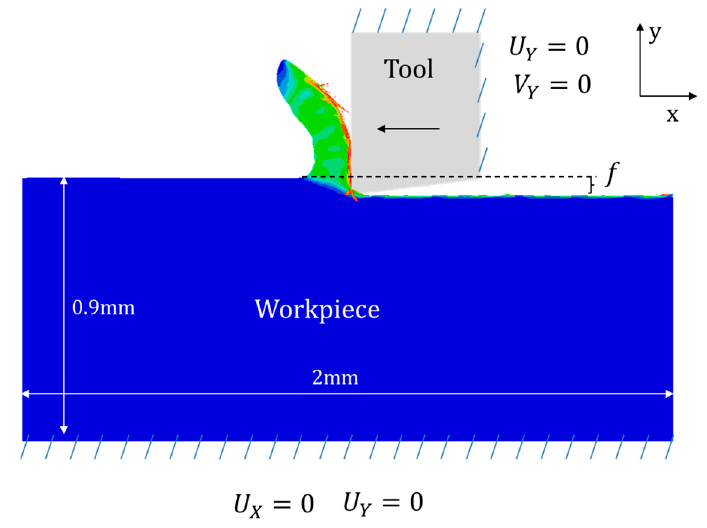
Figure 12. Model boundary conditions.